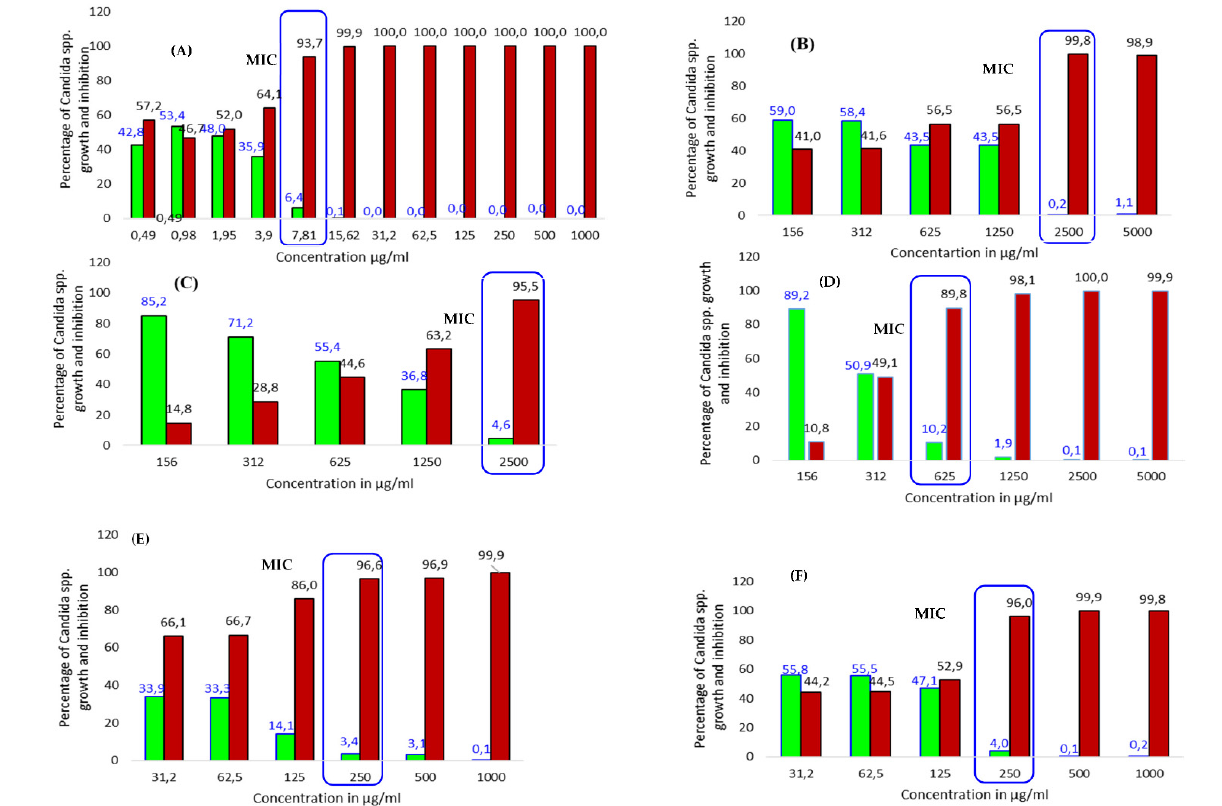
Figure 1. Anti- Candida activity of Terminalia brownii extracts, pure compounds and amphotericin B. ( A ) Amphotericin B against Candida tropicalis ; ( B ) decoction of the leaves against C. glabrata ; ( C ) maceration of the root bark against C. tropicalis ; ( D ) decoction of the leaves against C. albicans ; ( E ) quercetin against C. albicans ; ( F ) sitosterol against C. glabrata ; percentage of growth inhibition; p percentage of growth inhibition; percentage of growth.